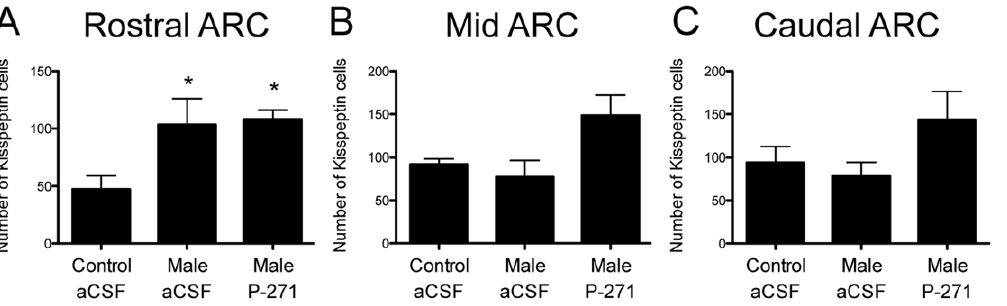
Figure 5. Male exposure in anestrous ewes increased the number of kisspeptin cells in the rostral ARC. The number of detectable kisspeptin neurons in the rostral ARC (A) was higher (P , 0.05) in ewes exposed to males compared to control aCSF treated ewes. The number of kisspeptin neurons did not differ in the mid (B), or caudal (C) ARC. Data are the mean 6 SEM, n=4 per group.